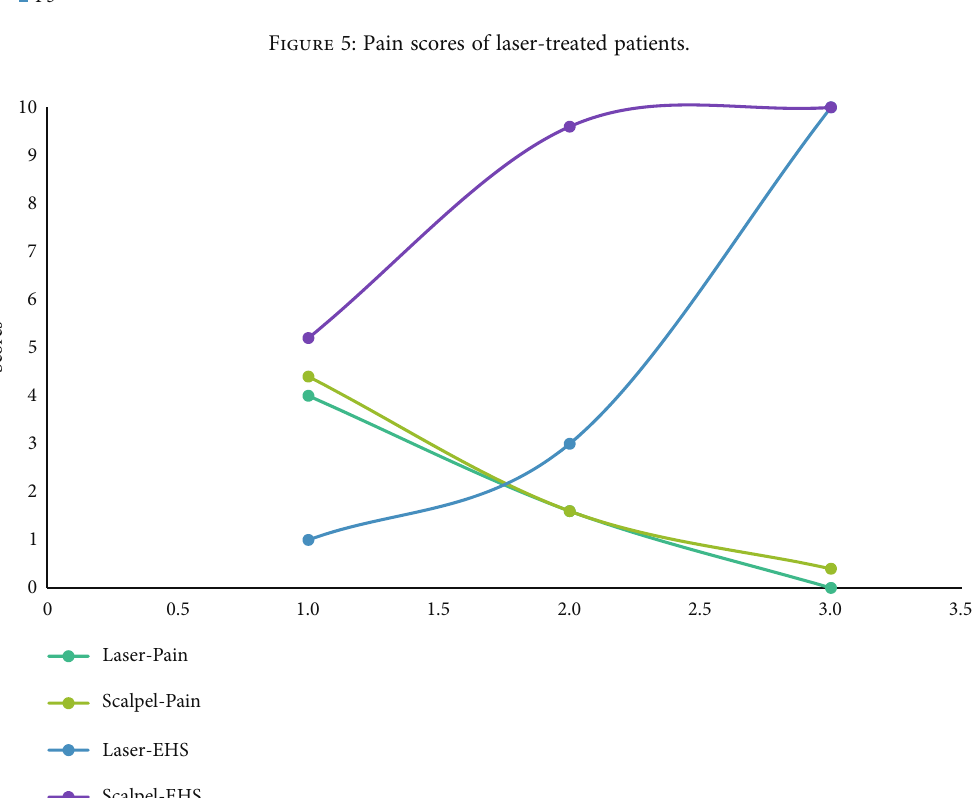
Figure 5: Pain scores of laser-treated patients.